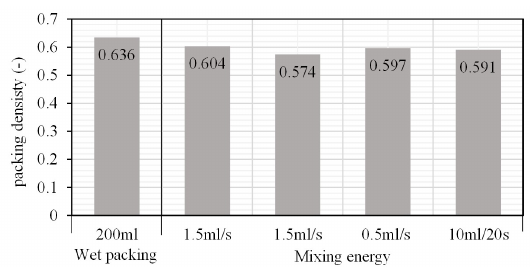
Figure 8: Packing density with the wet packing and the mixing energy